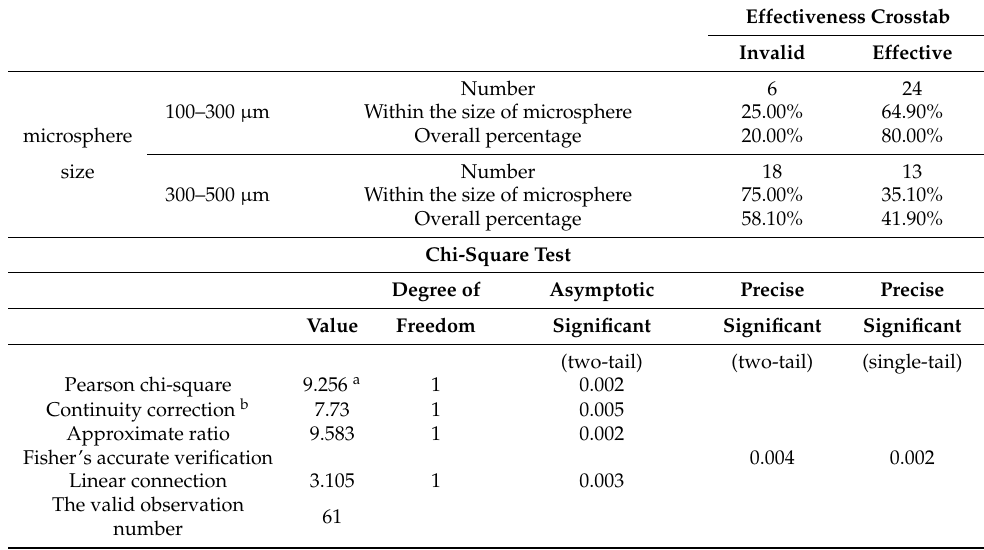
Table 6. Microsphere therapy, single-tumor only, mixed-size and 500–700 µ m-sized microspheres excluded.